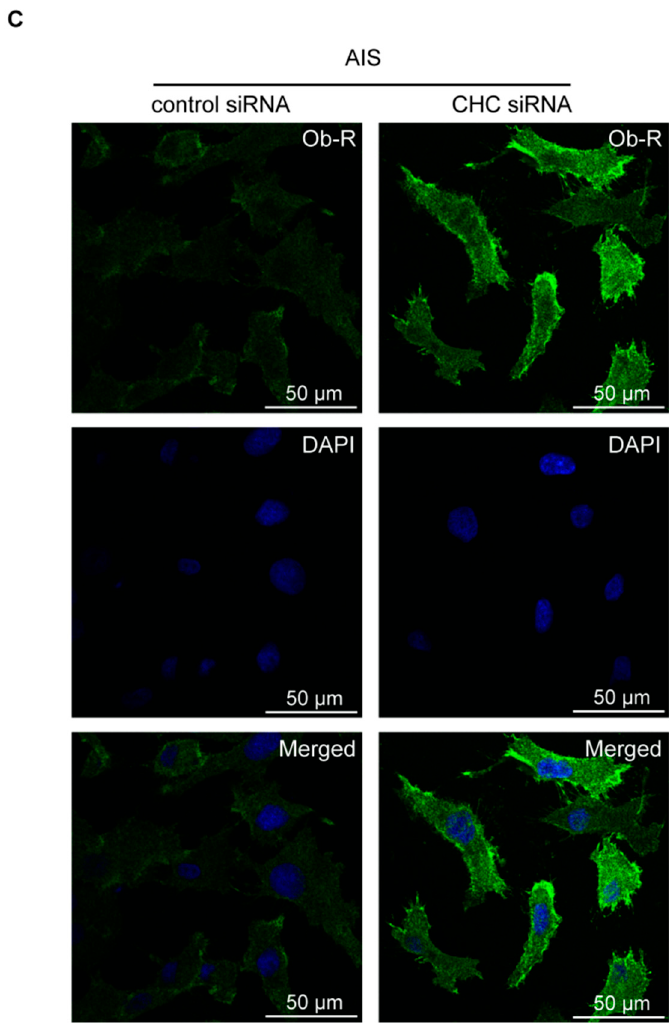
Figure 6. CHC knockdown upregulates Ob-R expression in the membrane of chondrocytes from AIS patients. ( A ) The efficiency of CHC knockdown was evaluated by Western blotting, and β -actin was used as an internal reference; ( B ) Chondrocytes from AIS patients were transfected with the control siRNA or CHC siRNA, followed by biotinylation of membrane protein. Then, the endocytosis of the biotinylated plasma membrane protein was induced with/without L -glutathione (GSH) buffer treatment. Alternatively, the cells were treated with GSH buffer but did not undergo the endocytosis procedure. The total and biotinylated plasma membrane proteins were extracted. Ob-R expression was analyzed by Western blotting. β -actin was used as an internal reference. Representative Western blots from three independent experiments are shown; ( C ) Chondrocytes from AIS patients were transfected with the control siRNA or CHC siRNA. Ob-R was labeled with green fluorescence, and the nuclei were stained with DAPI and shown as blue fluorescence. Strong signals of Ob-R were observed in the cells transfected with the CHC siRNA. Scale bars = 50 μ m.